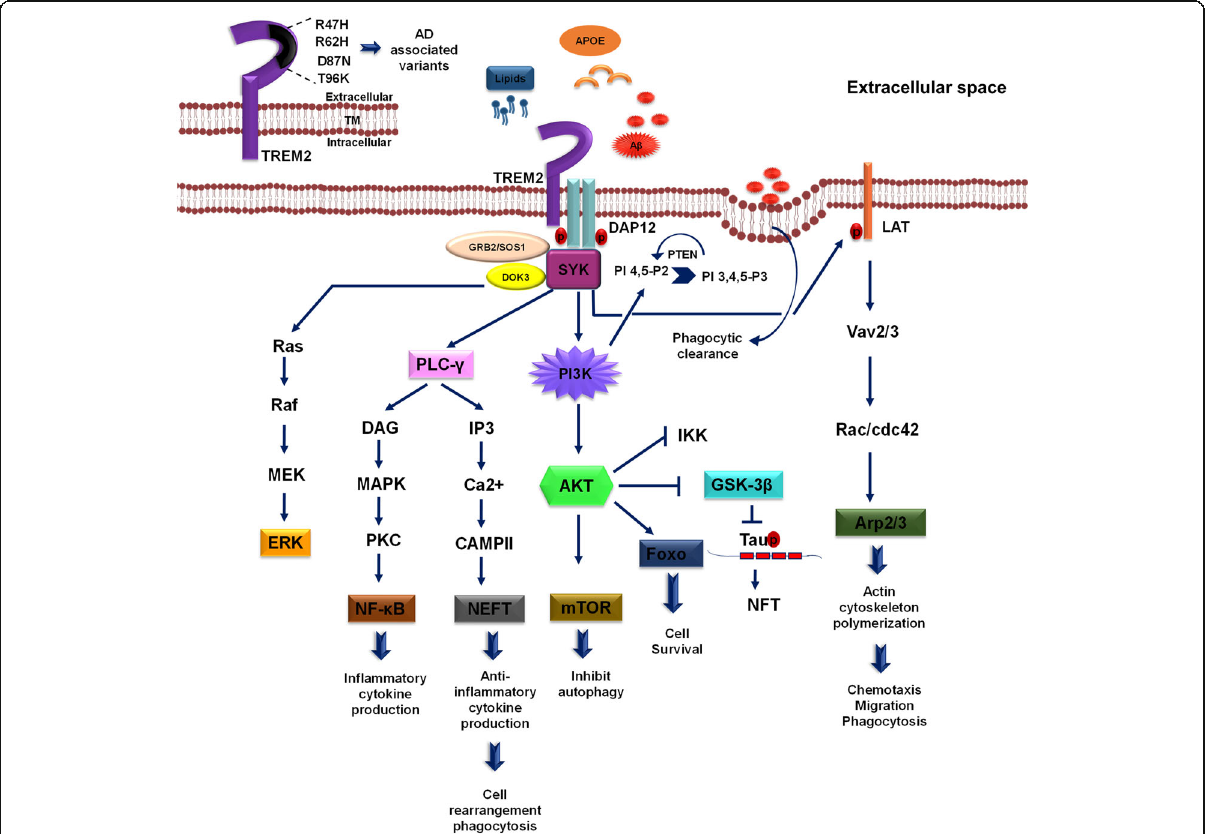
Fig. 2 PI3K/Akt signaling-mediated by TREM2. DAP12-mediated TREM2 signaling have been discussed in the figure. The possible ligands with respect to Alzheimer ’ s disease for TREM2 are lipids, APOE as well as amyloid- β . In the physiological condition, upon tyrosine phosphorylation of DAP12 ITAM leads to recruitment of Syk kinase along with the GRB/SOS1 and DOK3, which activates downstream signaling pathways of ERK, PLC- γ , PI3K/Akt as well as Vav. The activation of PLC- γ induces inflammatory cytokine response via DAG stimulation and anti-inflammatory cytokine response along with cell rearrangement and phagocytosis via elevating Ca 2+ response in the cell through IP3 activation. The main survival pathway of cell PI3K/Akt primarily activates mTOR pathway and Foxo that inhibit autophagy and induce cell survival, inhibits GSK-3 β that eventually reduce Tau phosphorylation in Alzheimer ’ s disease and suppress IKK, which is involved in the inflammatory response. PI3K activation increase formation of PI 3,4,5-P3, an important phosphoinositide in the process of phagocytosis and migration. Syk recruitment activates Vav2/3 molecule via LAT phosphorylation, which induces actin cytoskeleton polymerization important for chemotaxis, migration, and phagocytosis. TREM2 is one of the disease-linked genes in Alzheimer ’ s disease, the AD-related variant generally present in Ig-like extracellular domain of the receptor, which includes R47H, R62H, D87N,